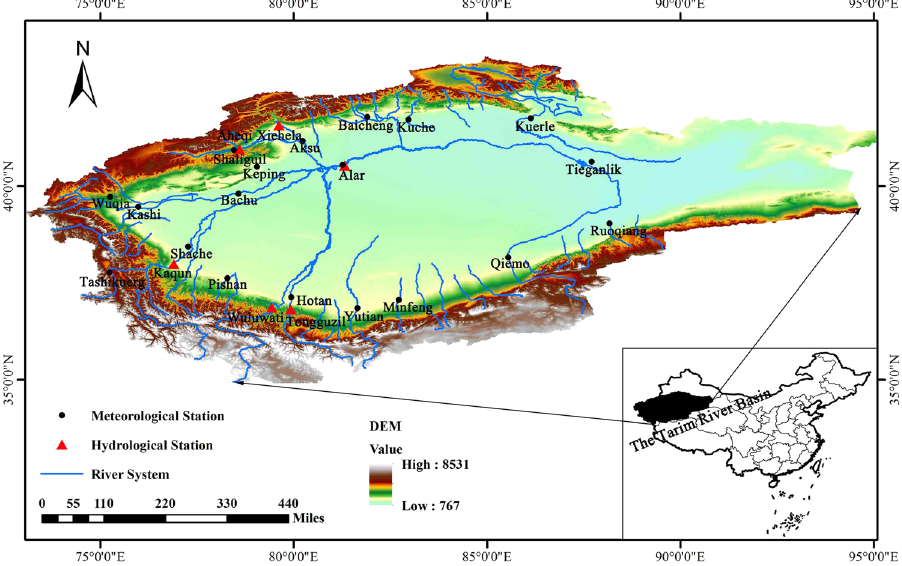
Figure 8. Sketch map of the Tarim River basin and location of the hydro-meteorological stations (Note: the map was generated with data available from the Chinese Geospatial Data Cloud using ESRI’s ArcGIS (version 10.1;